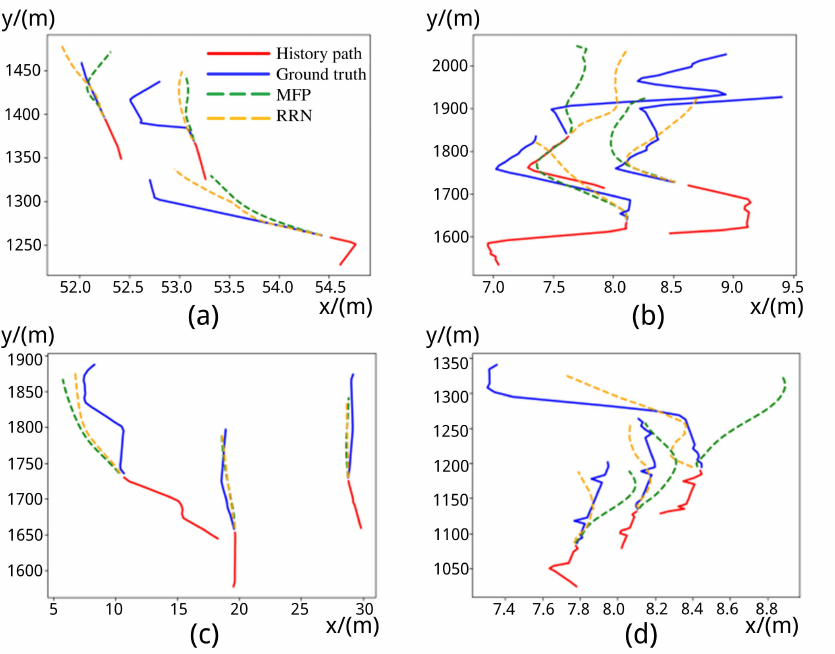
Figure 5. Examples of trajectory visualization on the NGSIM. We present the prediction results (in meters) of MFP and RRN in several cases. The red line denotes the history trajectories. The ground truth is shown by the blue line. The predicted trajectories of MFP and RRN are, respectively, plotted in the green and orange dotted lines. Subfigures ( a – d ) illustrate predicted trajectories of 4 various cases on the NGSIM dataset.